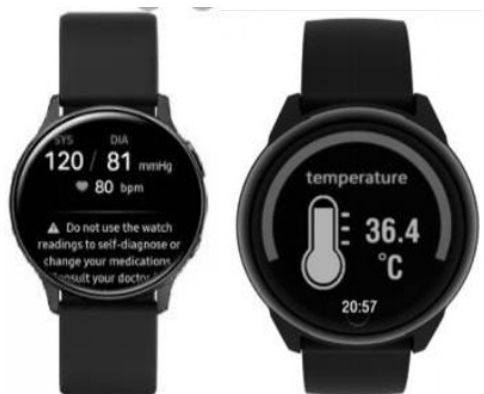
Figure 9. Alert Delivery time for Family Device 1